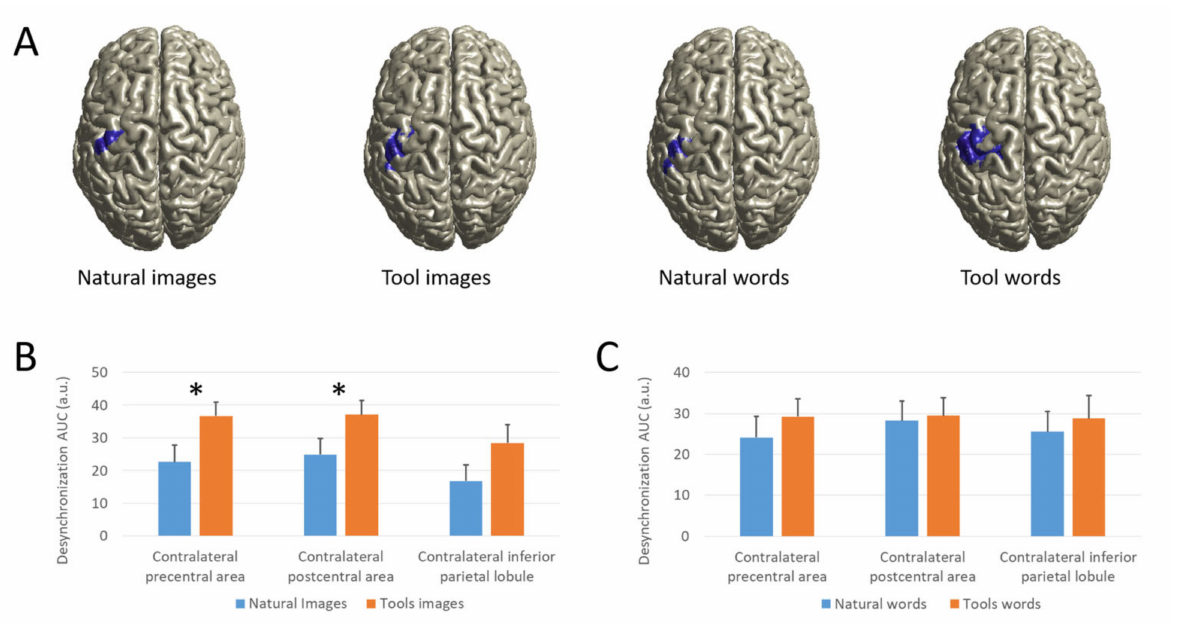
Figure 3. ( A ): Source analysis of beta activity. Source estimation projected onto the MNI template brain of grand-averaged power modulation obtained by contrasting − 1.5 to − 0.5 s vs. 0.5 to 1.5 s with respect to the cue onset in 15–25 Hz band for each condition. For illustrative purpose, only values greater than 80% of the maximum are shown. ( B , C ): Beta desynchronization AUC. Beta AUC values for natural and tools images ( B ) and nouns ( C ) condition. Note that the natural stimuli values are smaller than tools stimuli in both images and nouns condition in all areas, confirming the main effect of Category. Asterisk indicates significant difference in t -tests. Data are represented as mean ±